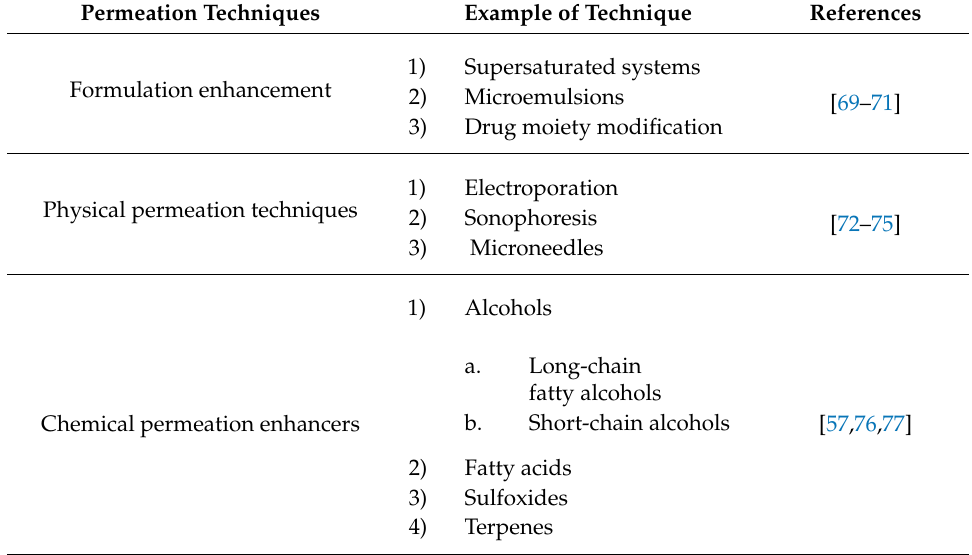
Table 2. Permeation techniques (including formulation enhancement strategies, physical permeation techniques, and chemical permeation enhancers) employed and examples of well-known applications of these